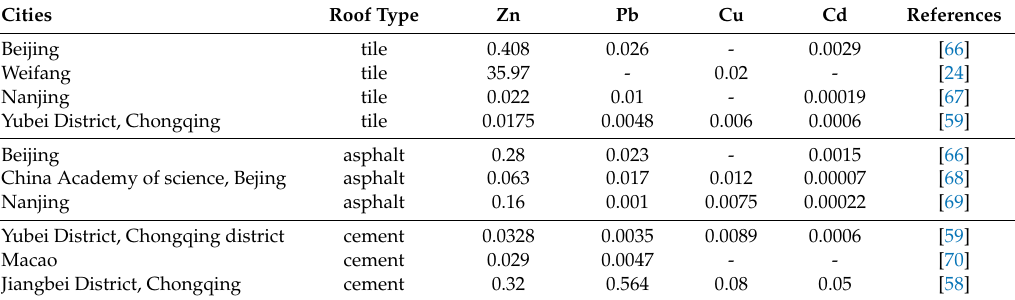
Table 4. The concentration of metals in roof runo ff